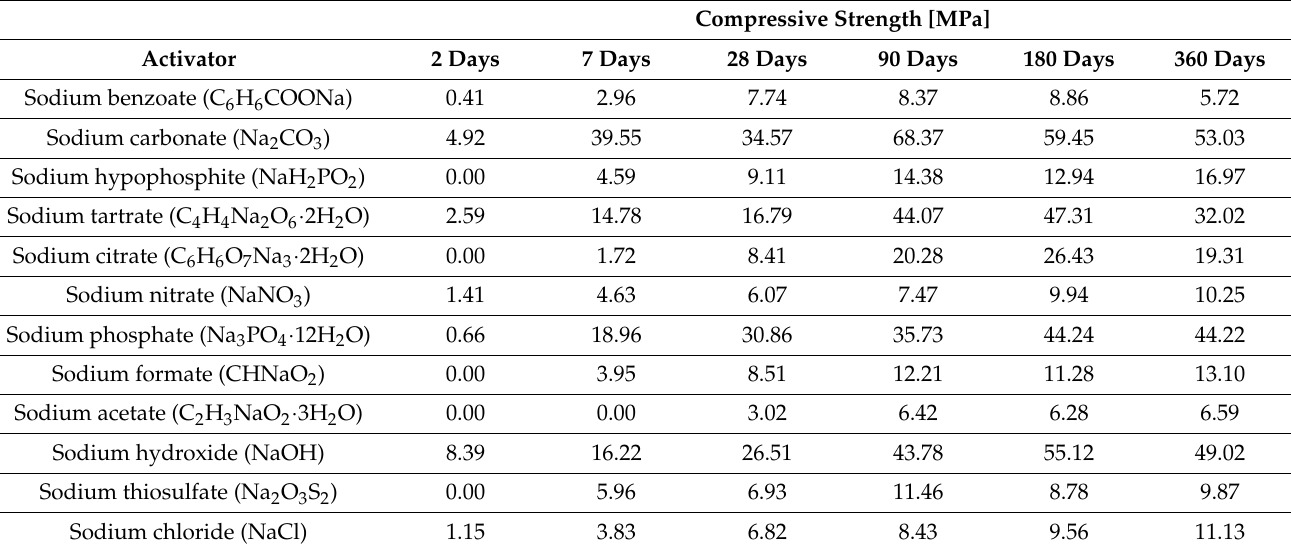
Table 2. Compressive strength of pastes activated with different sodium